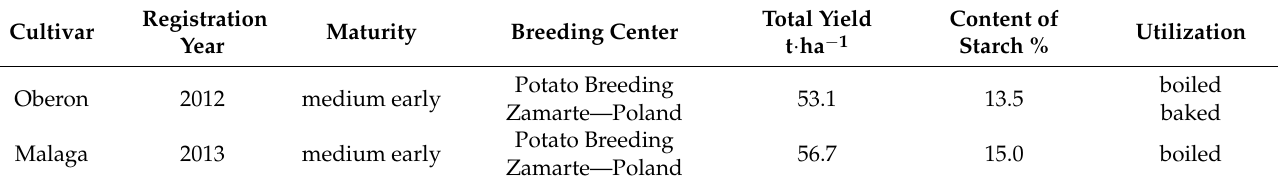
Table 1. Description of potato